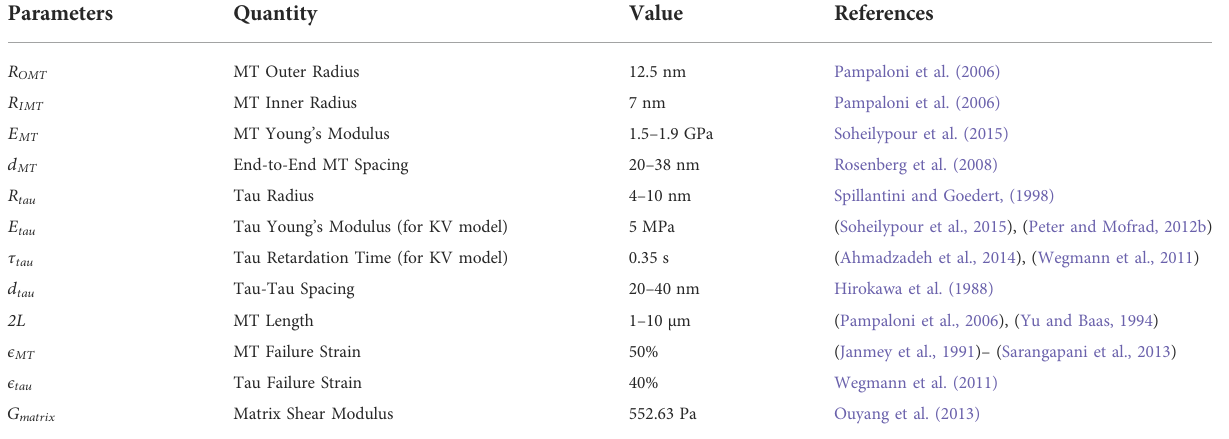
TABLE 1 Material and geometric properties of the cytoskeletal